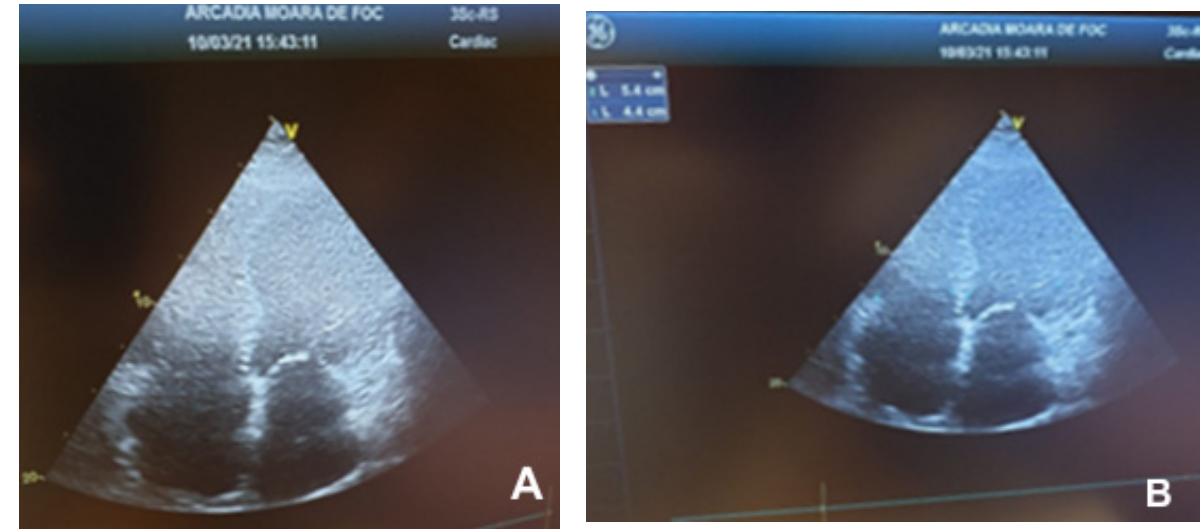
Figure 1. Dilated cardiomyopathy echocardiogram. ( A , B )—Apical 4 chamber view with global cardiomegaly and abnormal sphericity index.